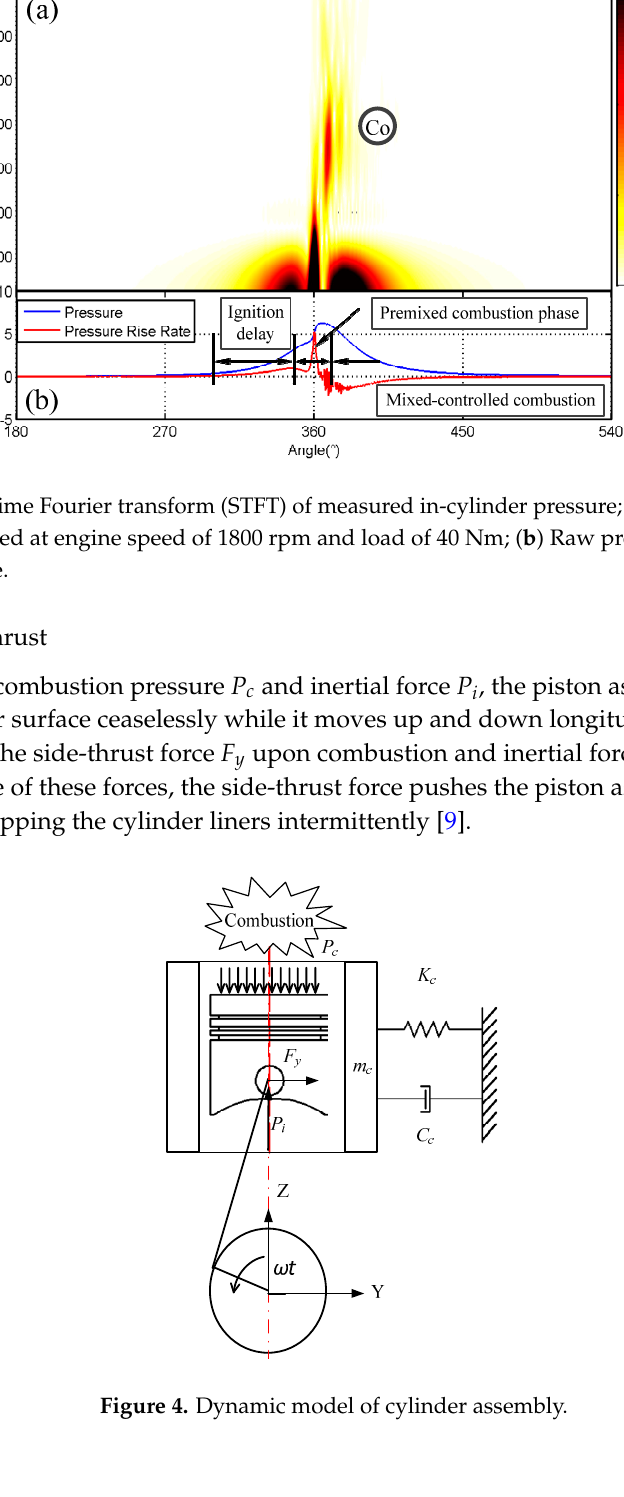
Figure 4. Dynamic model of cylinder assembly.